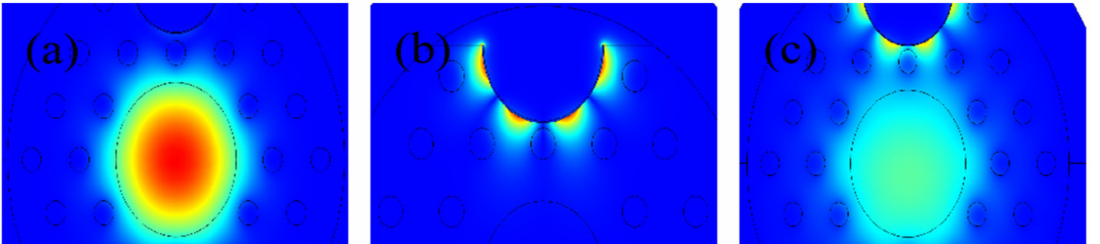
Figure 2. Electric field distribution showing optical coupling strength of ( a ) core mode, ( b ) SPP mode, and ( c ) the resonance coupling mode.